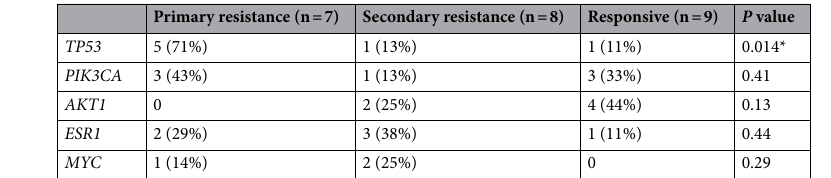
Table 4. Number of patients harboring somatic gene alterations according to endocrine responsiveness. * P < 0.05 is considered significant.